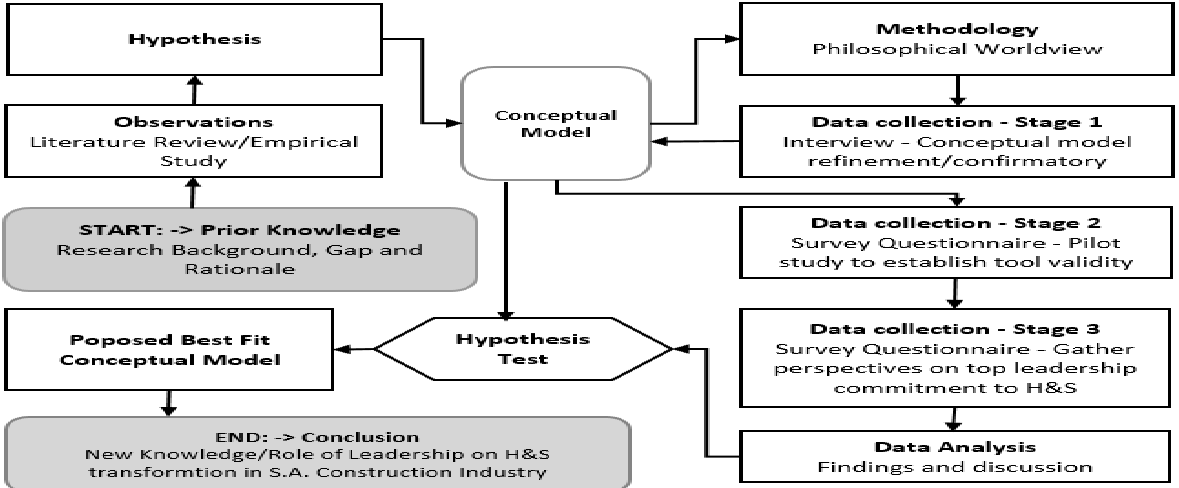
Figure 1. Research design outline (Adapted from Zikmund et al. [19]).